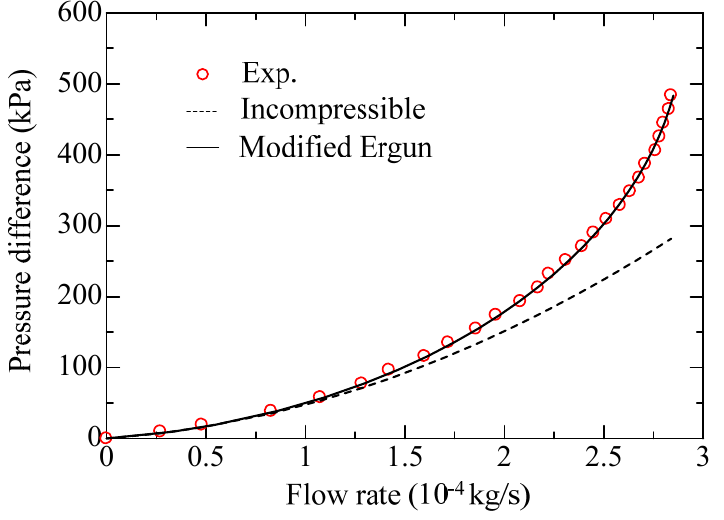
Figure 8. Pressure difference versus flow rate